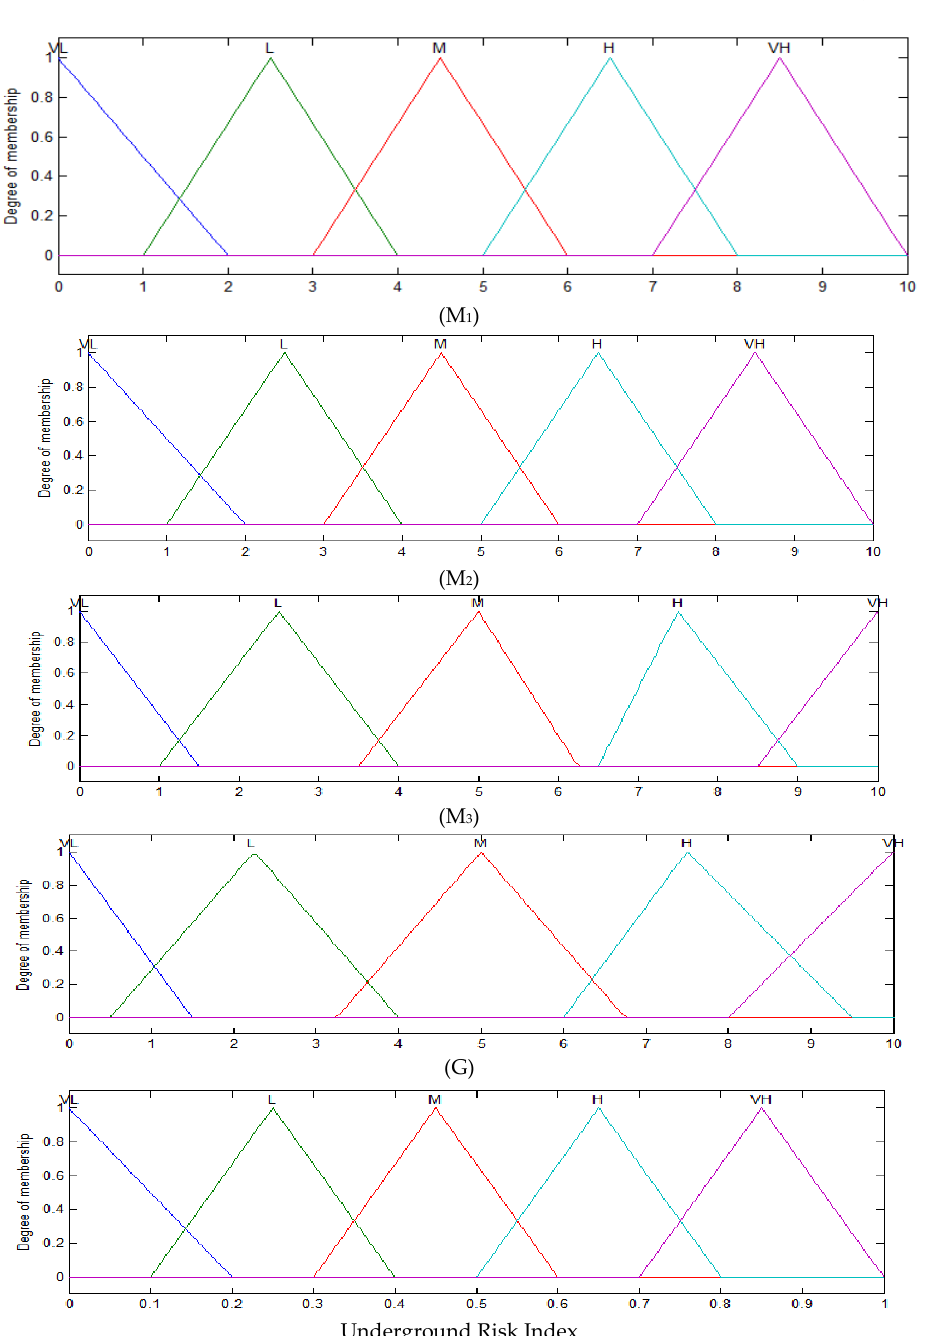
Figure 11. Membership functions for input variables (M 1 , M 2 , M 3 and G) and output variable (underground risk index) in the top-level fuzzy logic method.